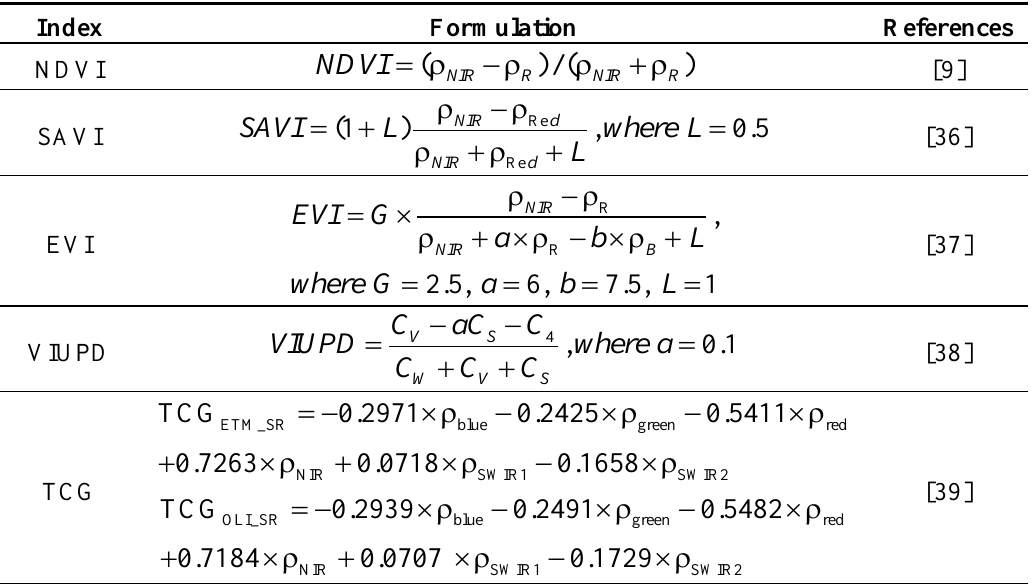
Table 2. Vegetation indices tested in this